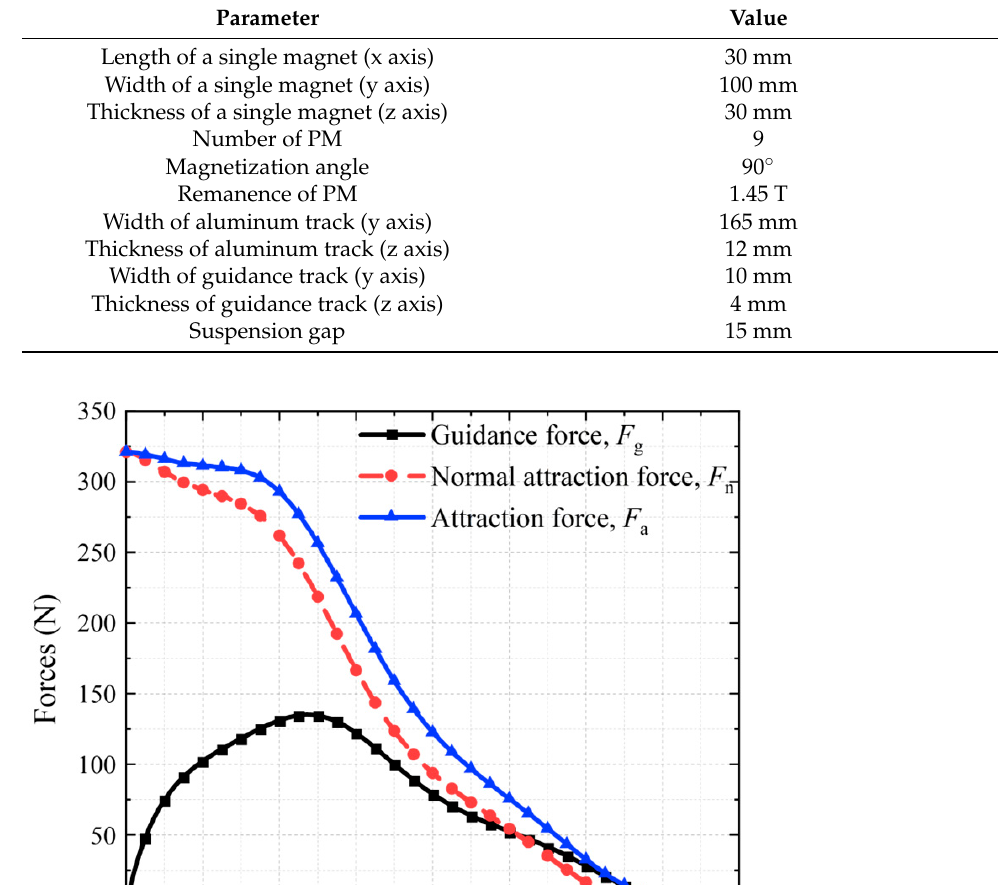
Table 2. Parameters of the guidance system finite element model.